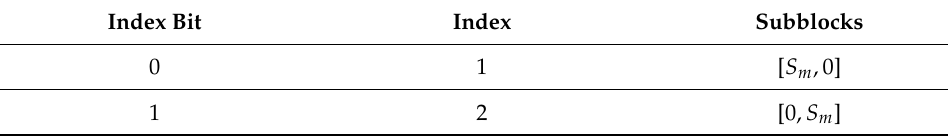
Table 1. Mapping table of OFDM-SM-IM with N = 2 and k = 1.